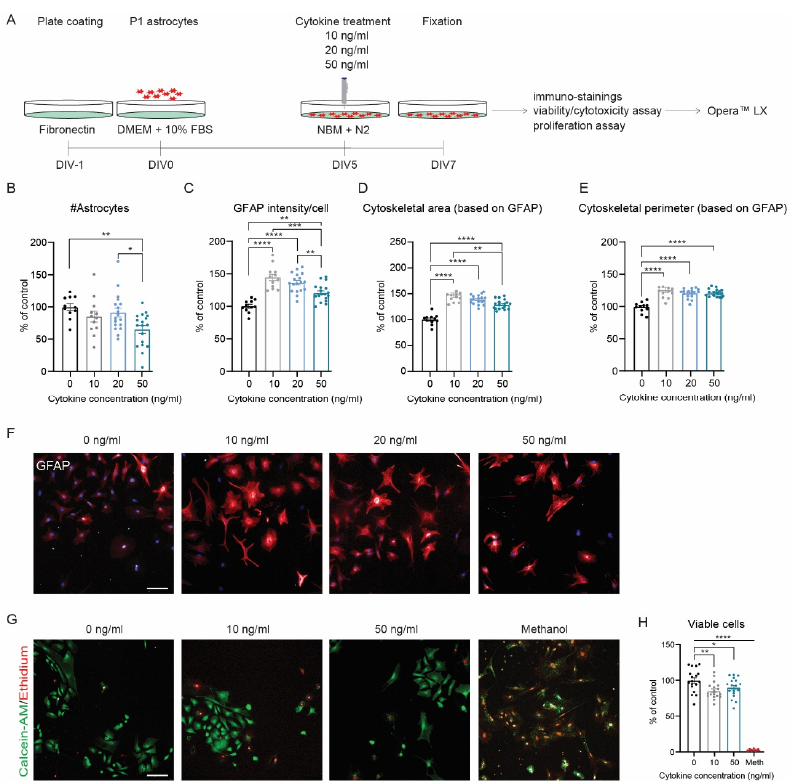
Figure 4. Cytokine-induced reactive astrogliosis in vitro: optimization of cytokine concentration. ( A ) Ex- perimental design. Analysis of ( B ) number of astrocytes, ( C ) GFAP intensity, ( D ) cytoskeletal area (based on GFAP intensity), and ( E ) cytoskeletal perimeter (based on GFAP intensity). ( F ) Representative images of GFAP (red) and DAPI (blue). N = 10–18 wells/condition; n = 24,701 (control), n = 22,980 (10 ng/mL), n = 36,734 (20 ng/mL), and n = 26,294 (50 ng/mL) astrocytes analyzed. ( G ) Representative images of alive (green) and dead (red) astrocytes upon incremental cytokine stimulation. ( H ) Analysis of the percentage of viable cells. N = 16–18 wells/condition; n = 4377 (control), n = 2876 (10 ng/mL), n = 1906 (50 ng/mL), and n = 2304 (methanol) astrocytes analyzed. Data were normalized to the non-stimulated condition. Data are presented as the mean ± SEM. One-way ANOVA with a Bonferroni post hoc